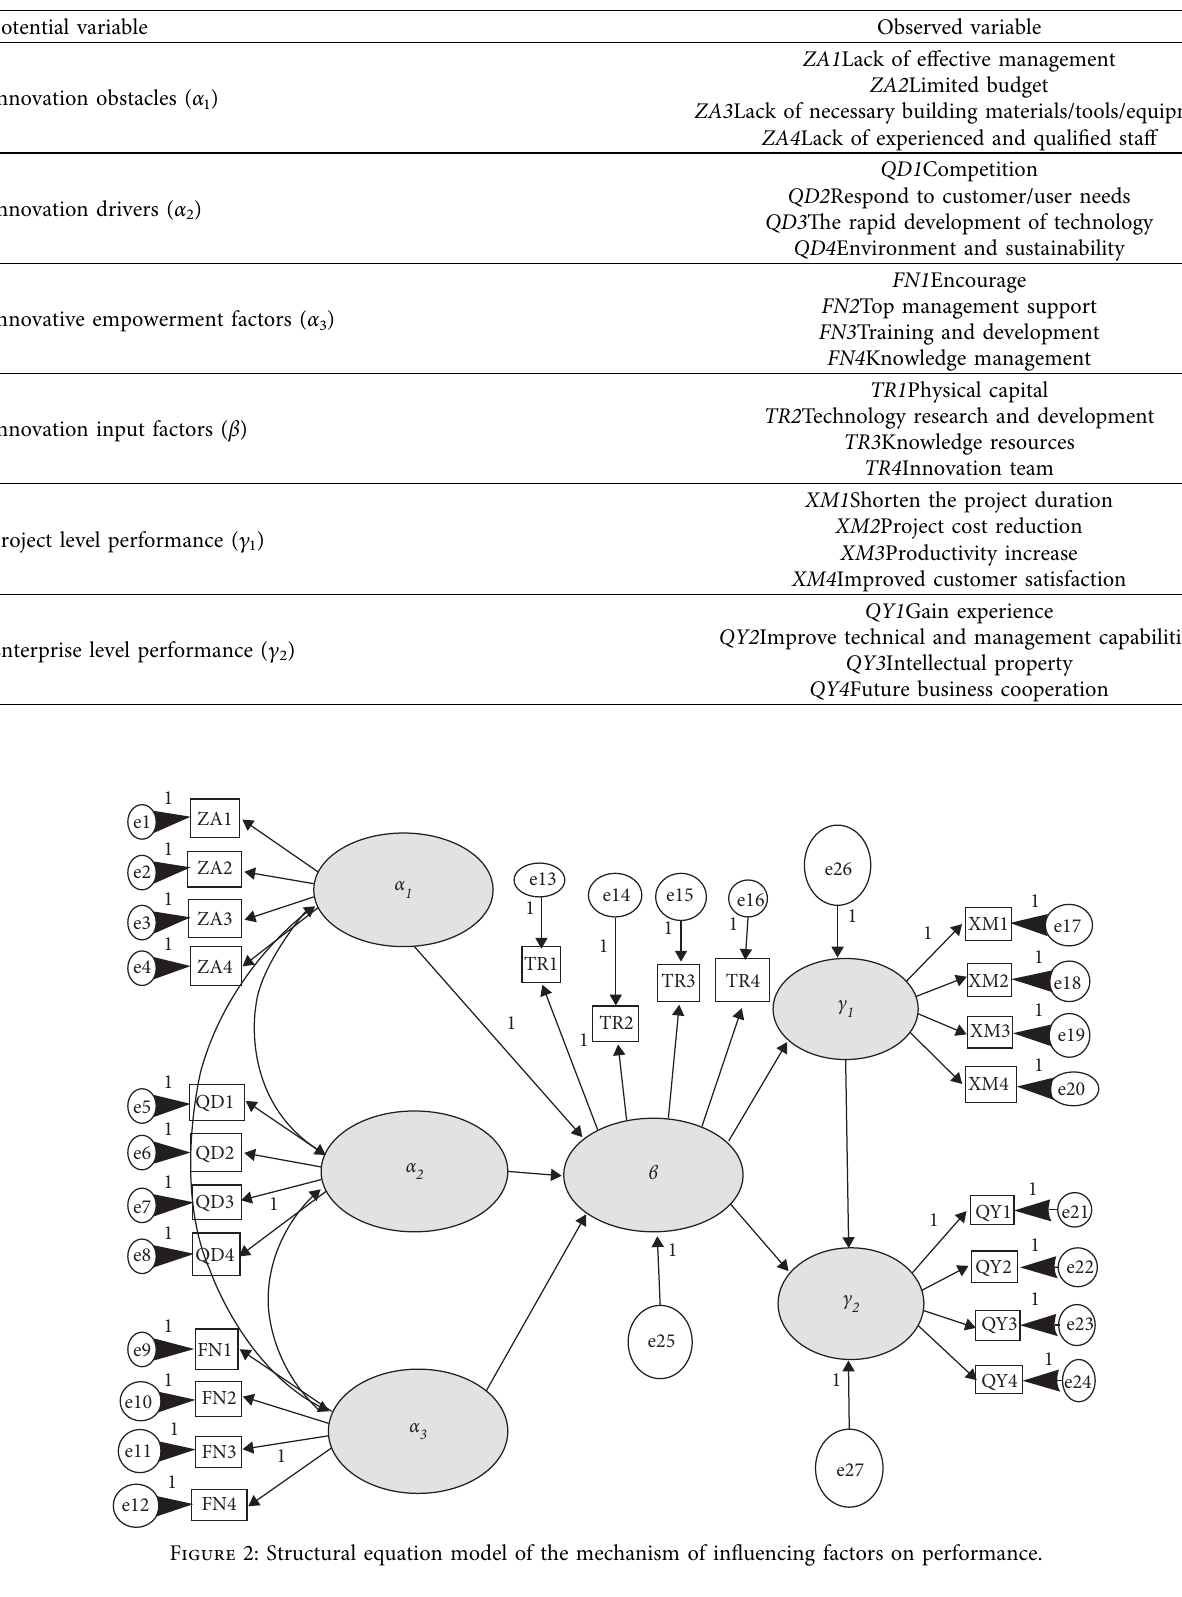
Table 1: List of influencing factors of construction project innovation.